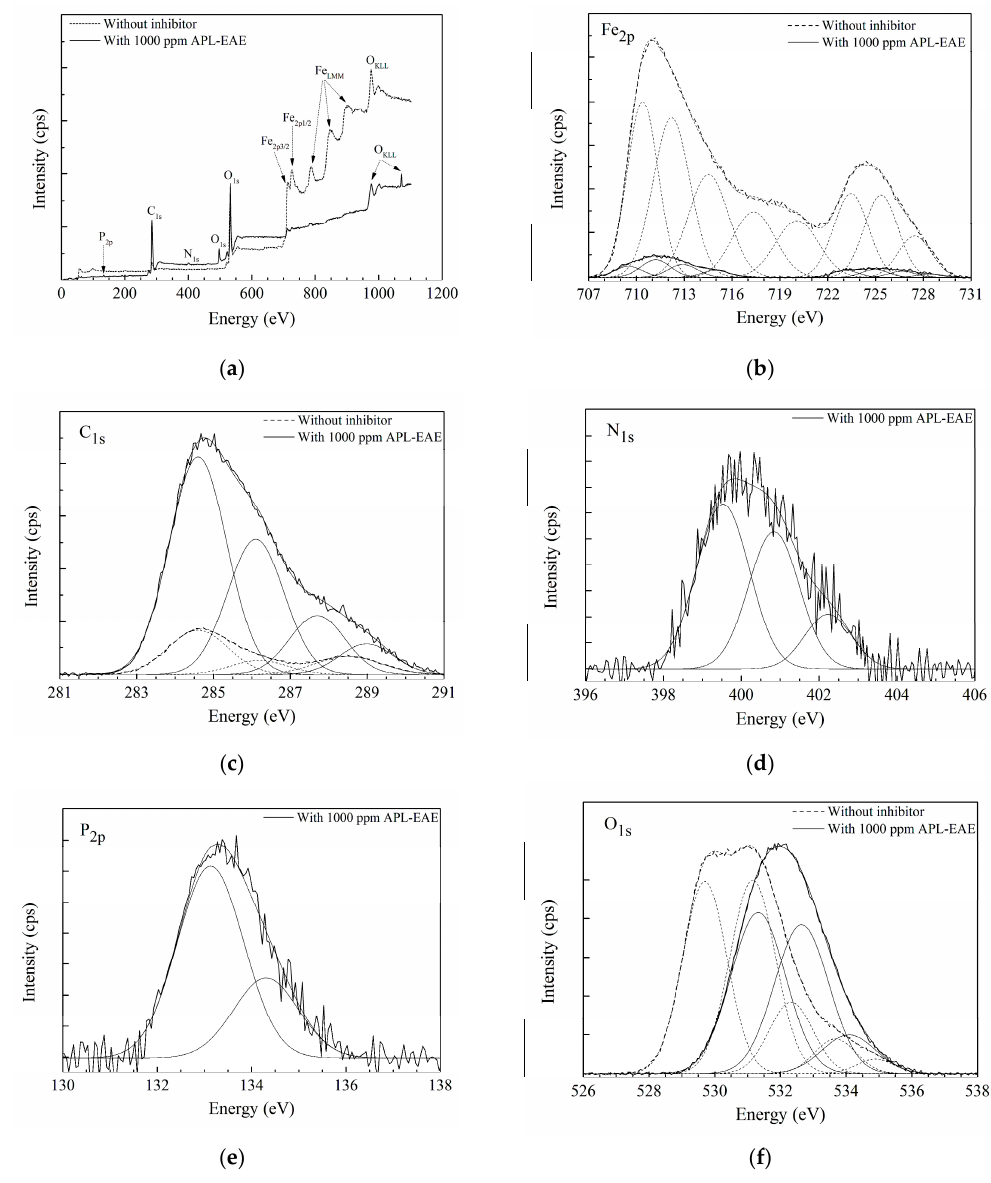
Figure 3. ( a ) Survey scan spectrum of XPS measurement, showing the growth of the protective film on the steel surface peak. Narrow scan spectra of ( b ) Fe; ( c ) C; ( d ) N; ( e ) P; and ( f ) O coverage of steel surface determined by XPS.